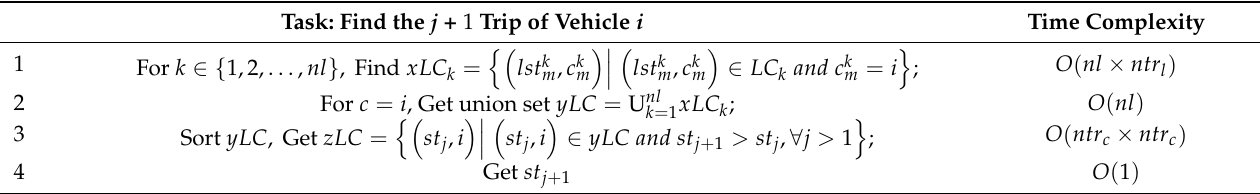
Table 2. The sub-search process with the line-based